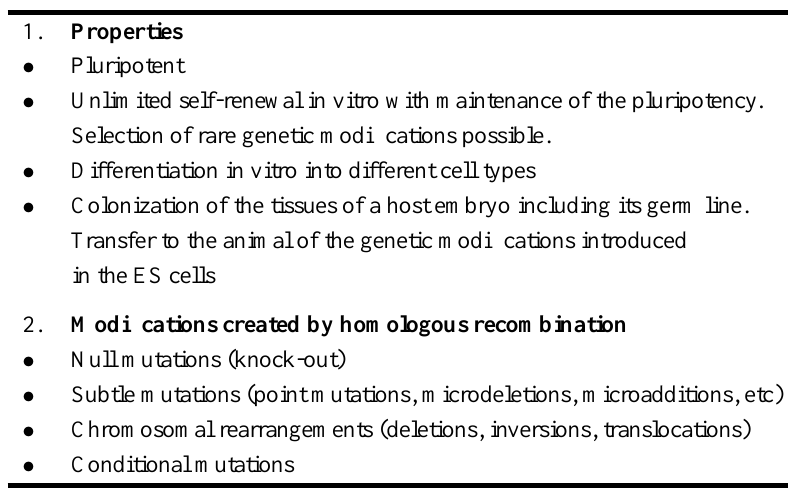
Mouse Embryonic Stem